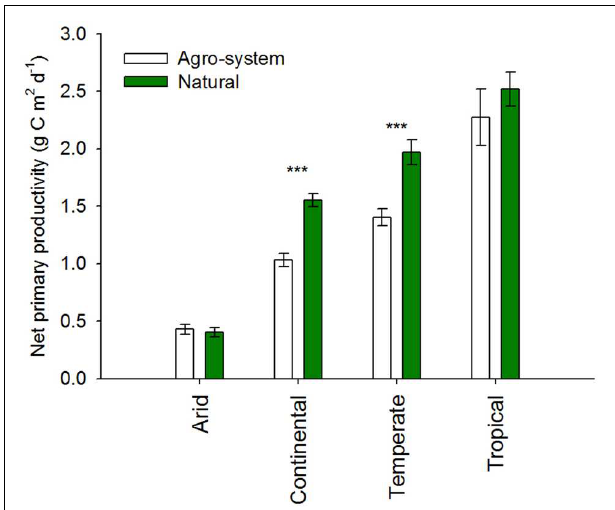
FIGURE 2 | Net primary productivity (measured as g C m 2 d − 1 ) of agricultural vs. natural systems in arid ( n = 26 and 70), continental ( n = 43 and 119), temperate ( n = 82 and 128) and tropical ( n = 14 and 36) regions. Data for primary productivity (g C m − 2 d − 1 ) was calculated from MODIS satellite imagery data as a monthly average from the 2004–2013 period using information with a 0.1 ◦ spatial resolution (http://neo.sci.gsfc.nasa.gov/). The main climate classes are based on global maps available for the most frequently used Köppen climate classification map (Kottek et al., 2006). ∗∗∗ P <